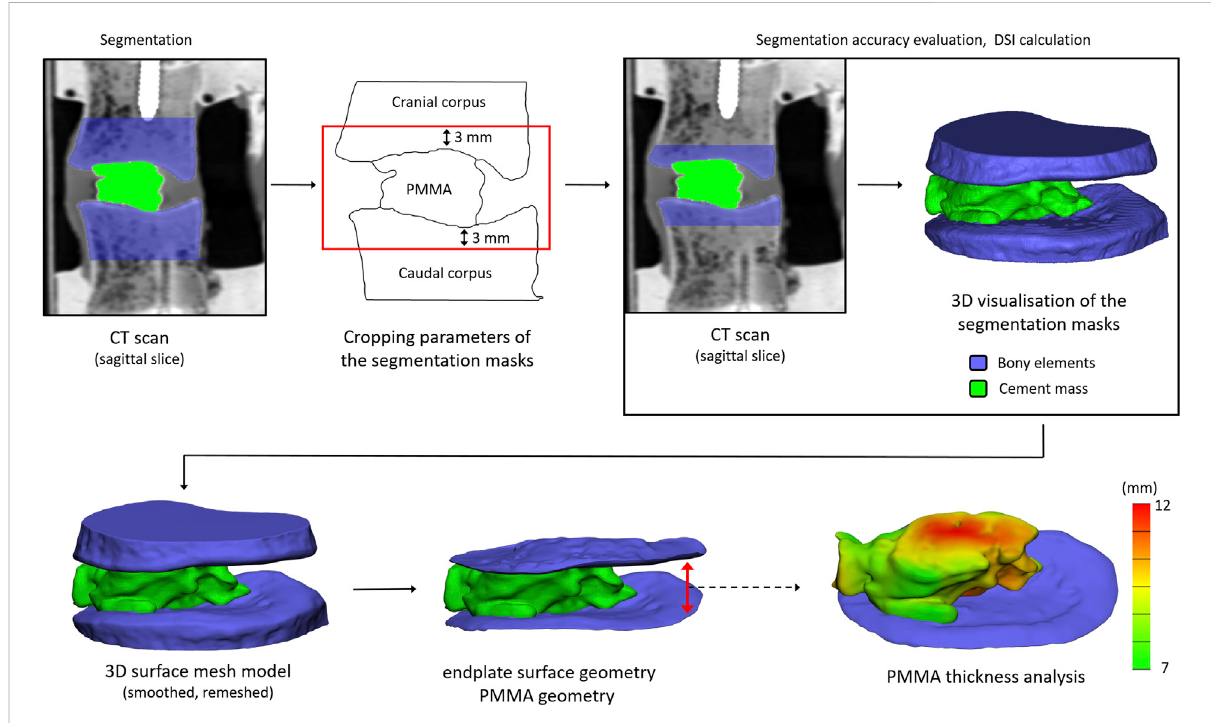
FIGURE 2 Work fl ow for the detection of the bony endplates and cement mass to visualize and assess the distribution of the cement in the intervertebral space, and to measure the cement